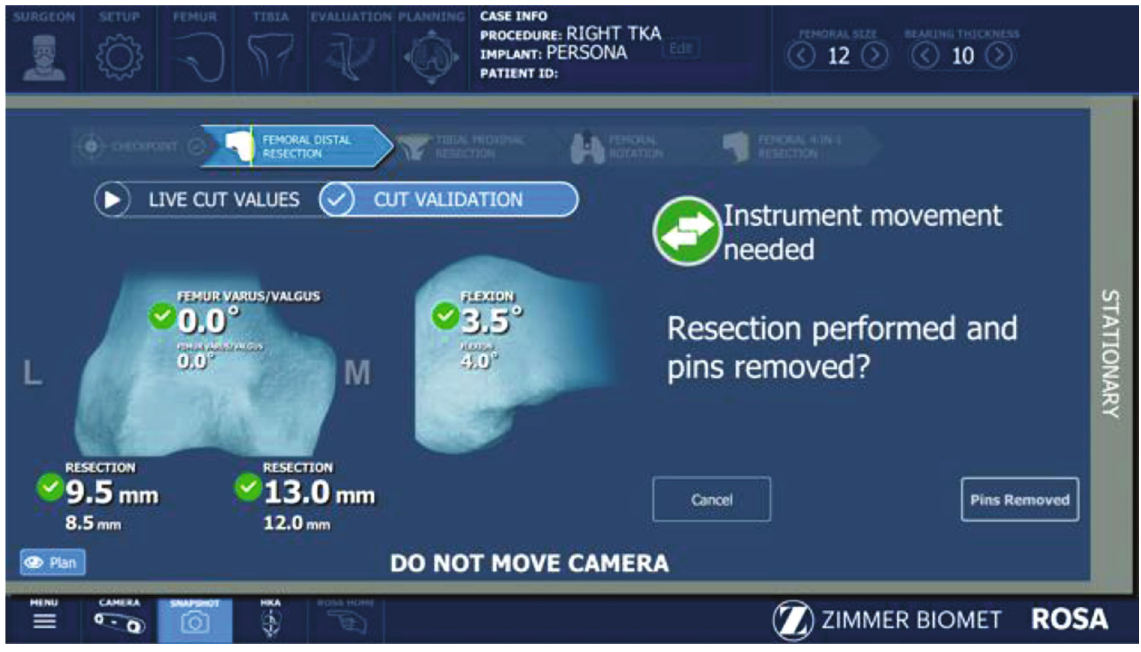
Figure 15: Femoral resections validated against ROSA-generated femoral resection plan.